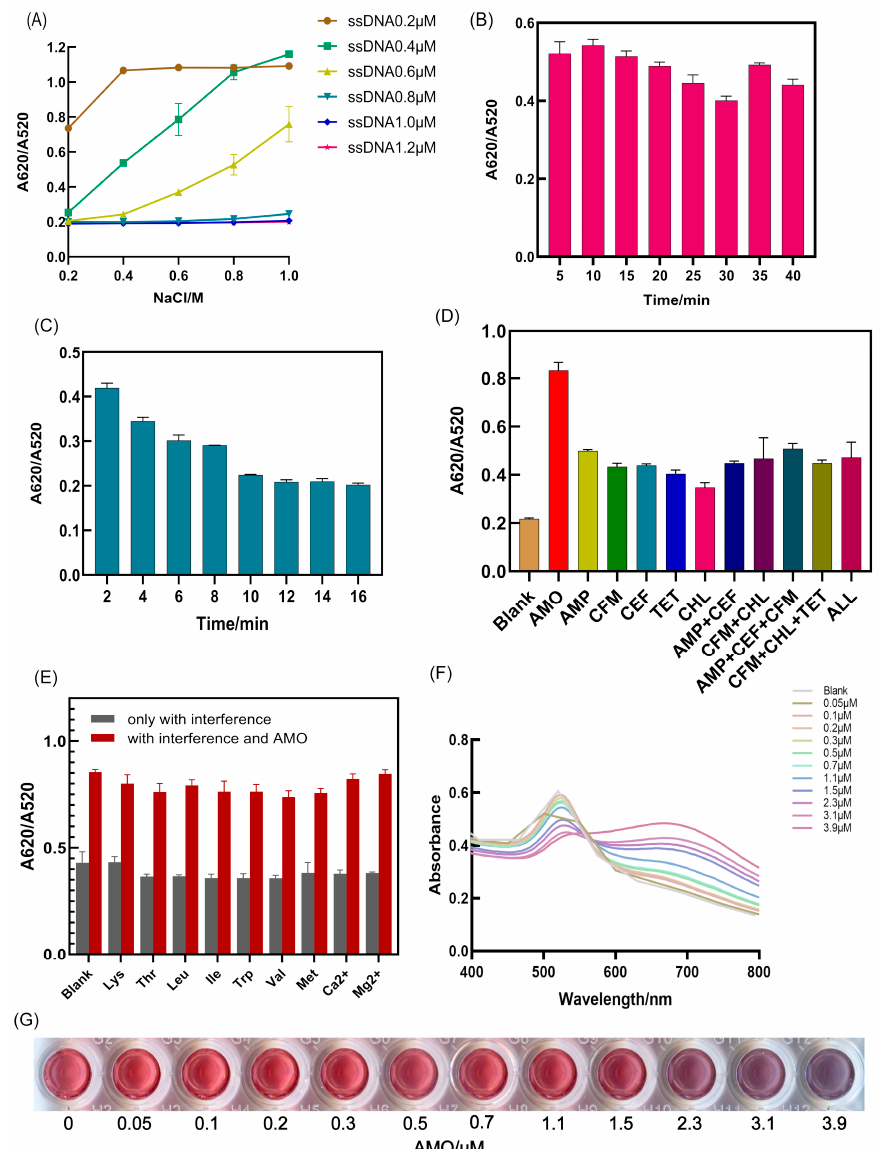
Figure 2. ( A ) Aggregation of different concentrations of ssDNA coupled to AuNPs in the presence of different concentrations of NaCl. ( B ) Effect of the incubation time of ssDNA with AuNPs on the protection of AuNPs by ssDNA. ( C ) Effect of reaction time between AMO and AuNPs-ssDNA. ( D ) Selectivity of the reaction system in aqueous solution. The concentrations of AMP, CFM, CEF, TET, and CHL were 6 µ M, the mixture solutions were mixed at the same concentration and the concentration of AMO was 3 µ M. ( E ) Interference resistance of the reaction system. Interference including amino acids and cations, the concentrations of interference used were all 50 µ M and AMO was 3 µ M. ( F ) Spectral scan result of the decided AMO concentrations. ( G ) Color change of the decided AMO